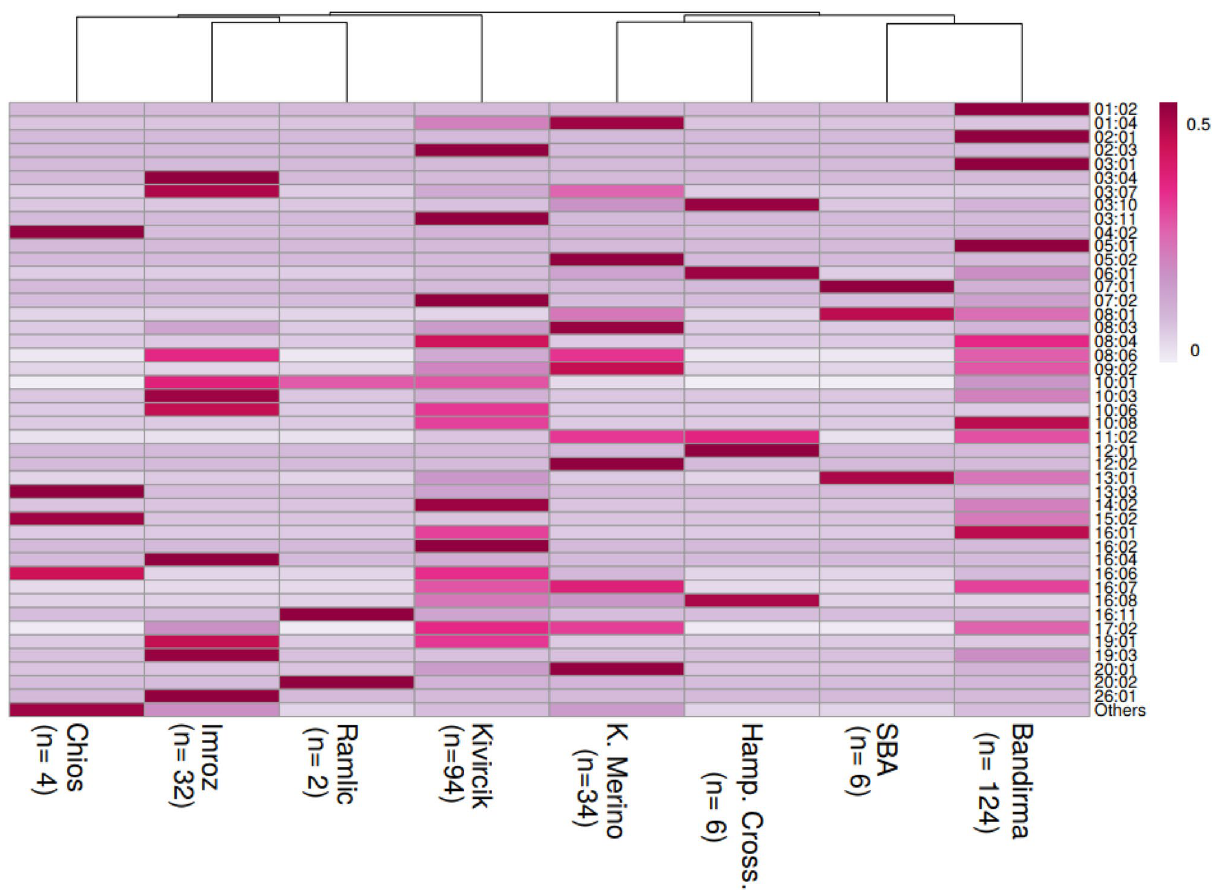
Figure 1. Distribution of DRB1 haplotypes according to